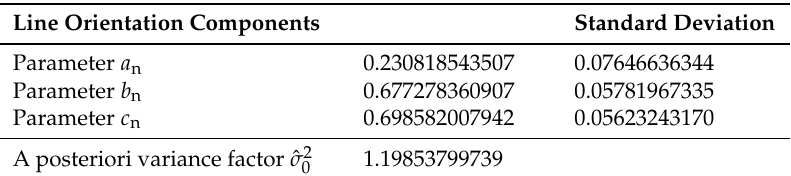
Table 4. Direct WTLS solution from Section